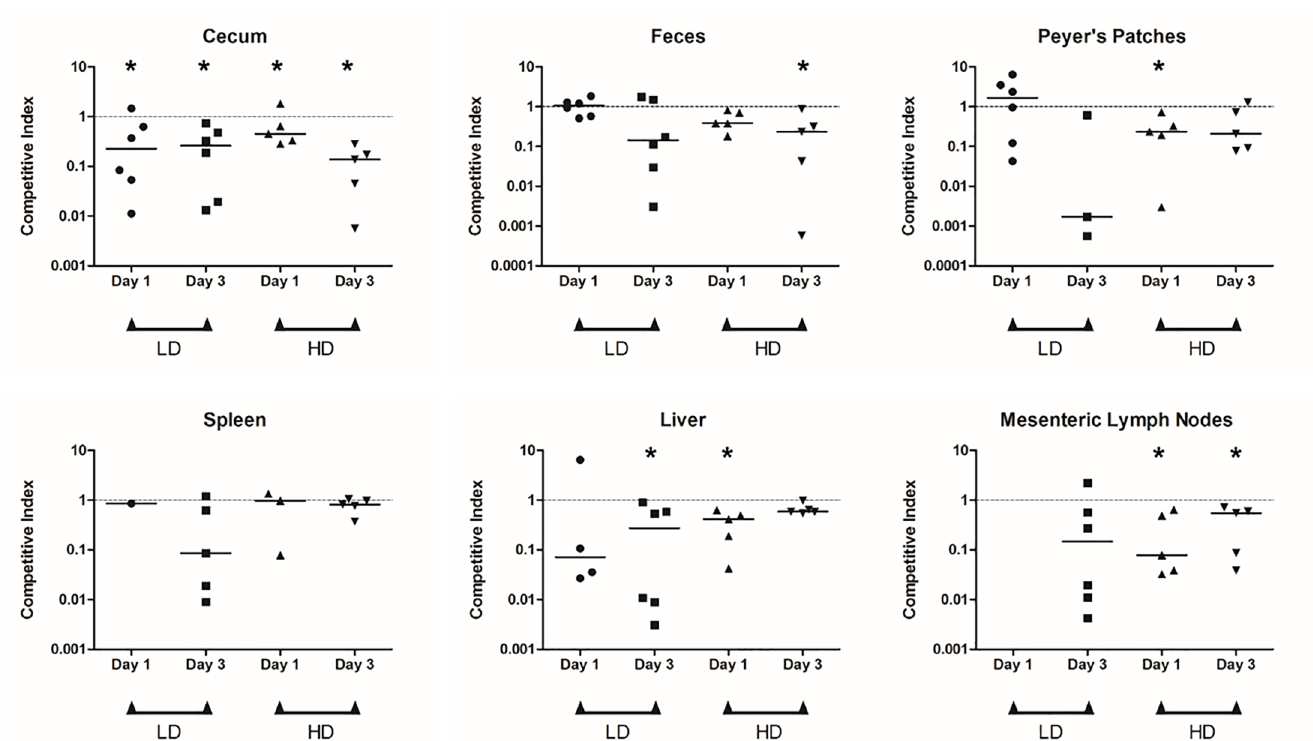
Fig 1. In vivo competition assays in C57BL/6 mice with indole treated Salmonella . Competitive index (CI) values for the indole treated Salmonella versus the control in different organs harvested from infected mice (n = 5) at days 1 and 3 post inoculation. Two inoculum doses were tested- low dose (LD; ~5 × 10 7 cfu) and high dose (HD; ~5 × 10 8 cfu) and several organs—cecum, Peyer’s patches, spleen, liver and mesenteric lymph nodes—were harvested. Feces were collected prior to euthanization. The organs were homogenized and serial dilutions plated to obtain cfu counts that were used to calculate the CI values. Each symbol (circle, square, upright triangle and downward triangle) on the plot represents a mouse from the respective group (LD day 1, LD day 3, HD day 1 and HD day 3, respectively). Lack of symbol indicates that no colonies were observed with that sample. For organs where indole treated Salmonella were absent but solvent treated Salmonella were present, CI was calculated assuming a cfu of 1 for the indole treated Salmonella . The horizontal bar represents the median of the observed CI values. (cid:3) denotes significantly lower ( p < 0.05) recovery of indole-treated Salmonella relative to solvent-treated Salmonella , as represented by the plotted CI values, using the Wilcoxon matched pair